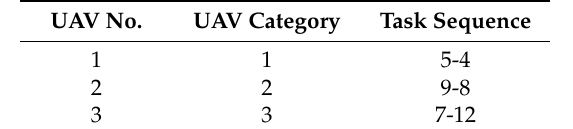
Table 5. Flight Sequence of Each UAV in Scenario 1.